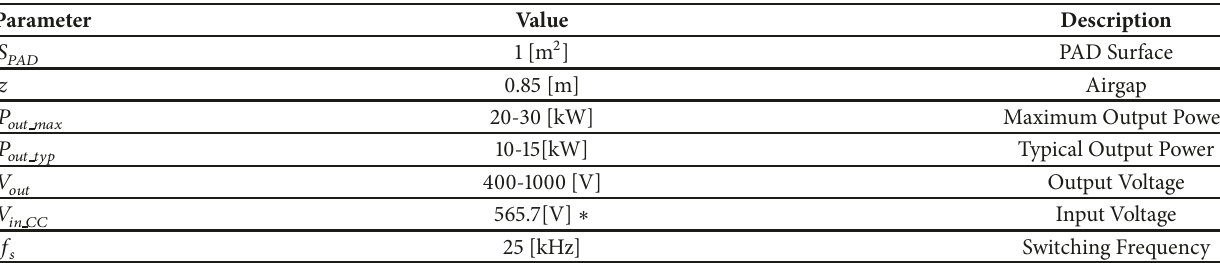
Table 2: Proposed system characteristics.